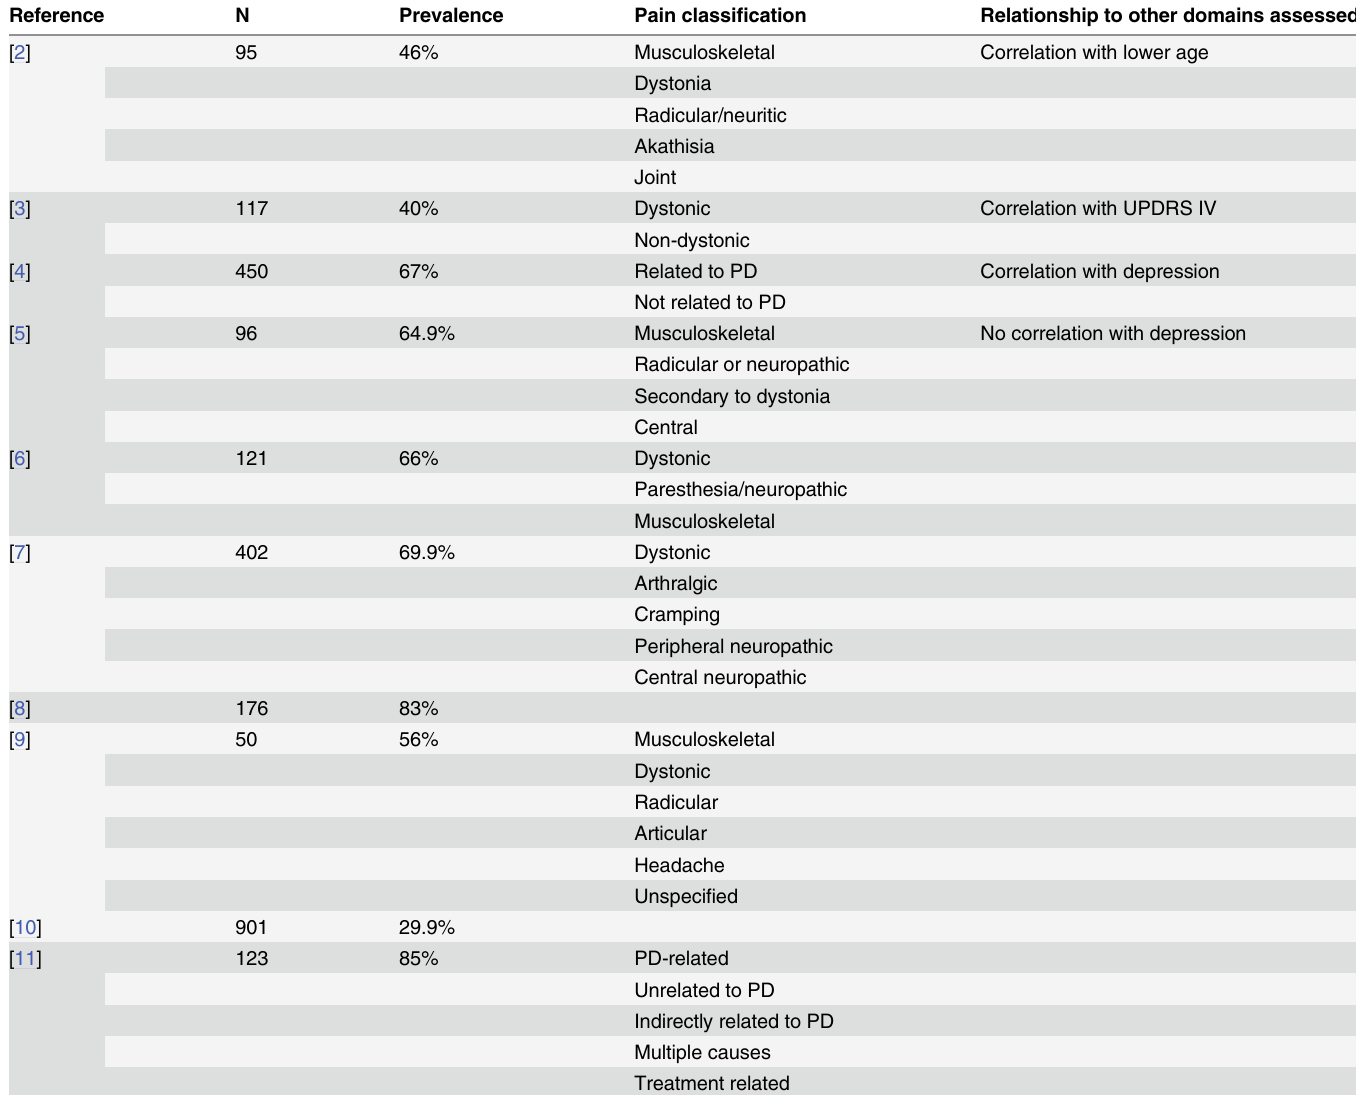
Table 1. Overview of studies on the prevalence of pain in Parkinson´s disease.